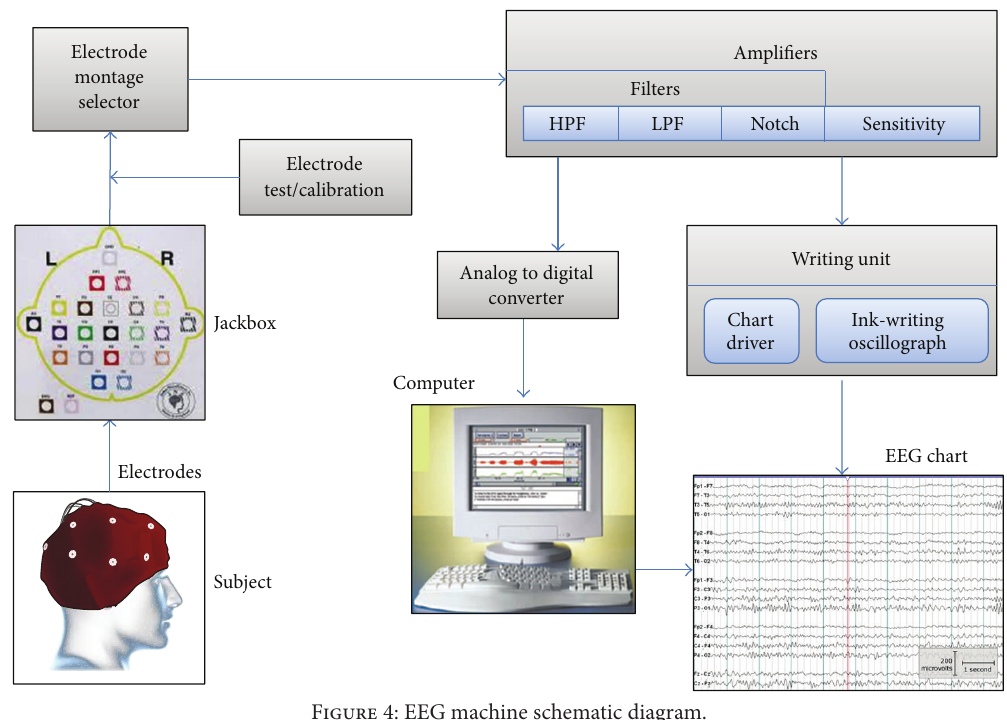
Figure 4: EEG machine schematic diagram.